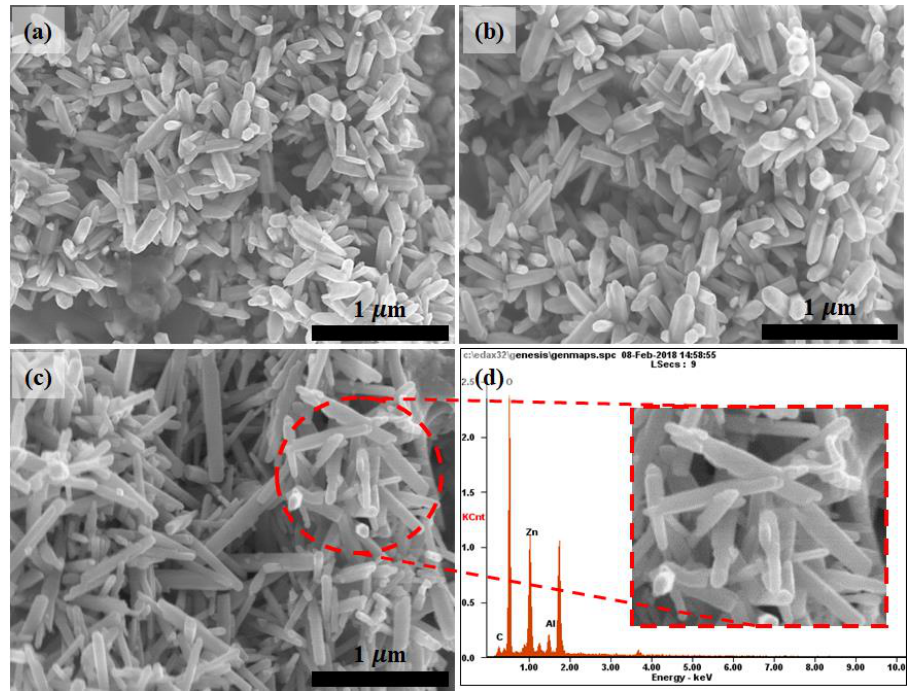
Figure 3. FESEM topographies of the deposited hexagonal MMO nanorods at different molar ratio; ( a ) ZA-6 , ( b ) ZA-7 , and ( c ) ZA-8 and ( d ) EDX spectrum of ZA-8 .